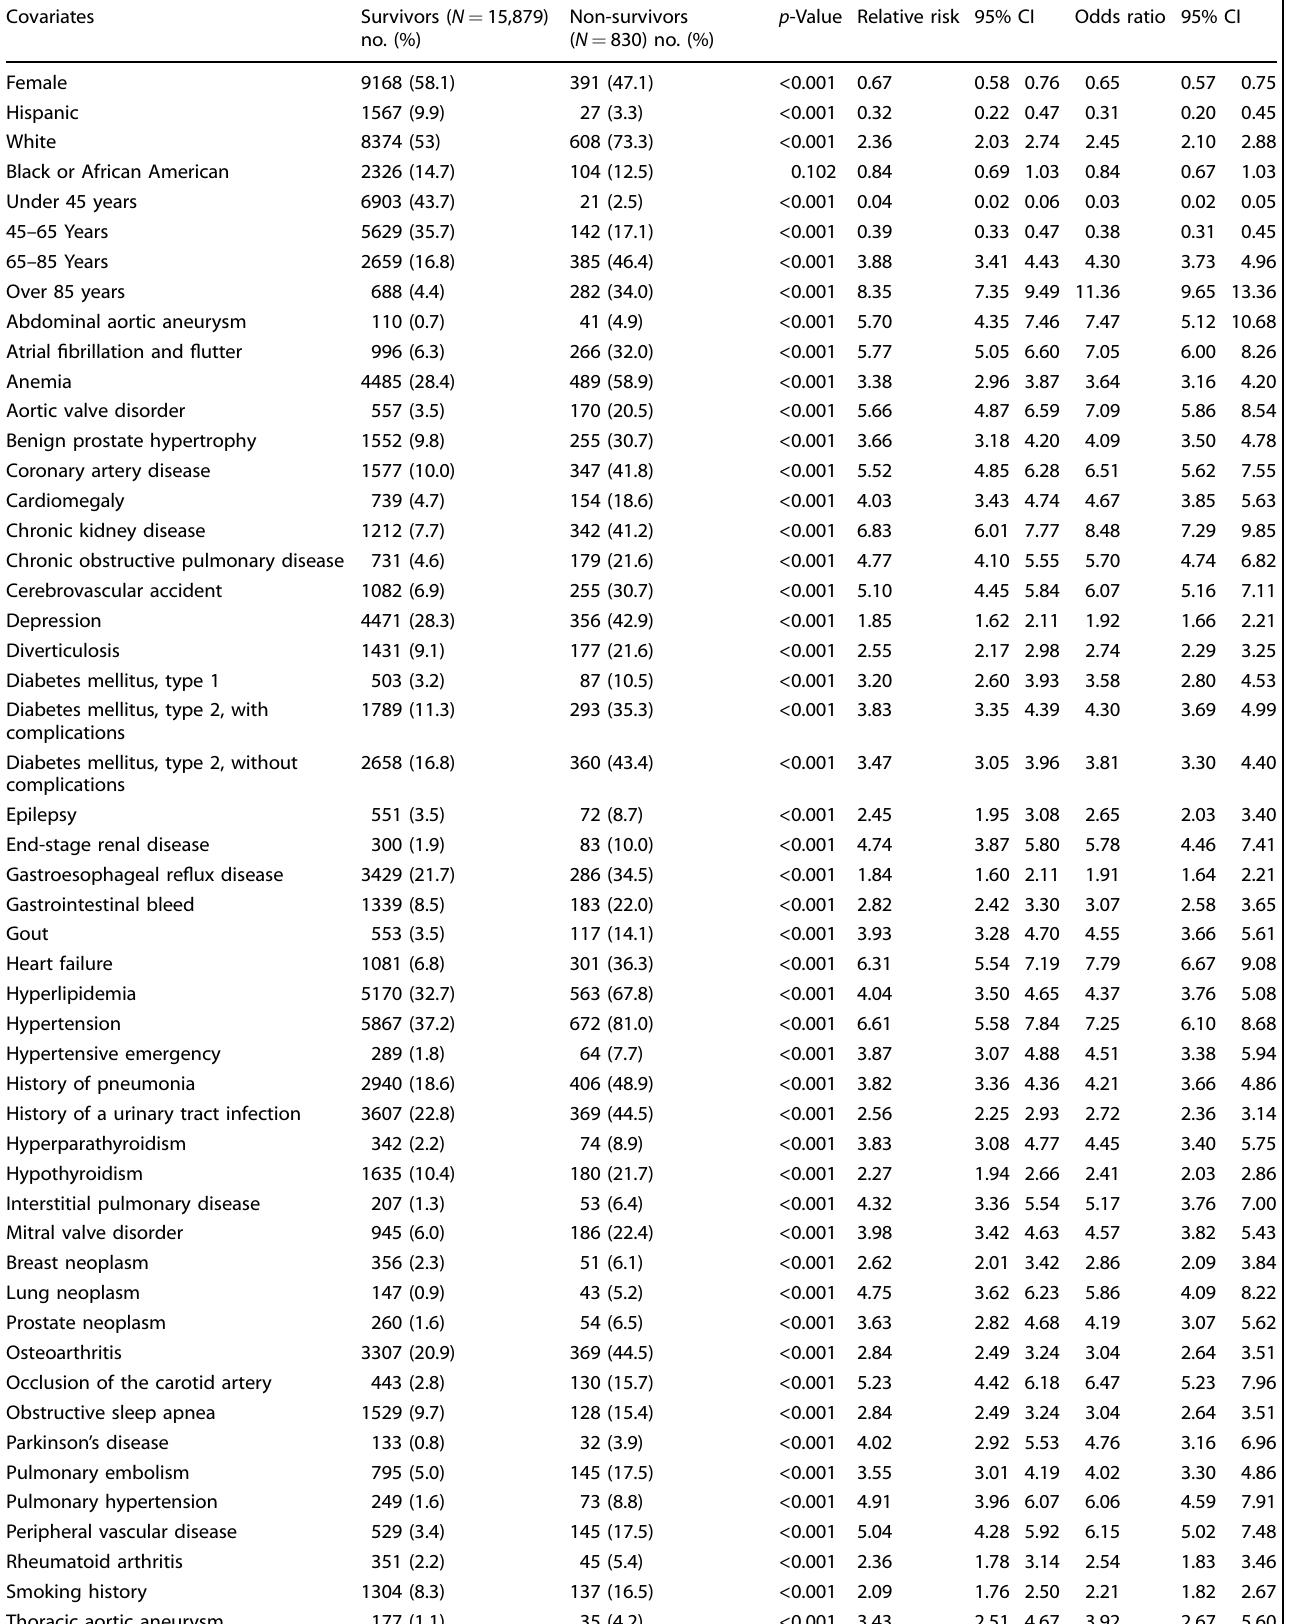
Table 1. Univariate analysis of the 51 covariates (46 clinical + 5